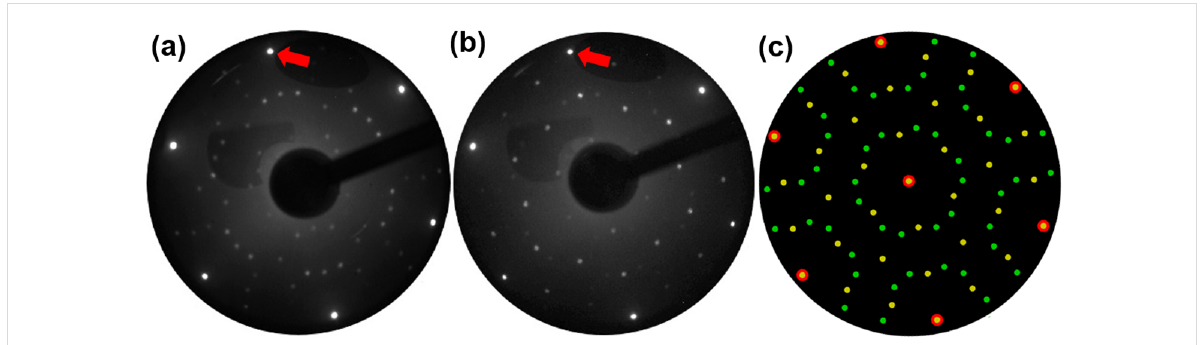
Figure 1: (a) LEED pattern obtained at an electron energy of 55 eV from Al(111) with 0.6 ML of Ge deposited at a rate of 0.55 ML/min at a sample temperature of around 200 °C. Diffraction spots corresponding to (3×3) and two domains of ( √ 7× √ 7) periodicities are clearly observed. (b) LEED pattern obtained at an electron energy of 50 eV from a sample deposited at a rate of 0.37 ML/min. The (3×3) spots are dominating while the ( √ 7× √ 7) spots are significantly weaker compared to (a). One (1×1) diffraction spot from Al(111) is indicated by a red arrow in (a) and (b). (c) Schematic LEED pattern showing the combination of (3×3) and two domains of ( √ 7× √ 7) reconstructions. Red circles, yellow spots and blue spots represent Al (1×1), (3×3) and two domains of ( √ 7× √ 7), respectively.